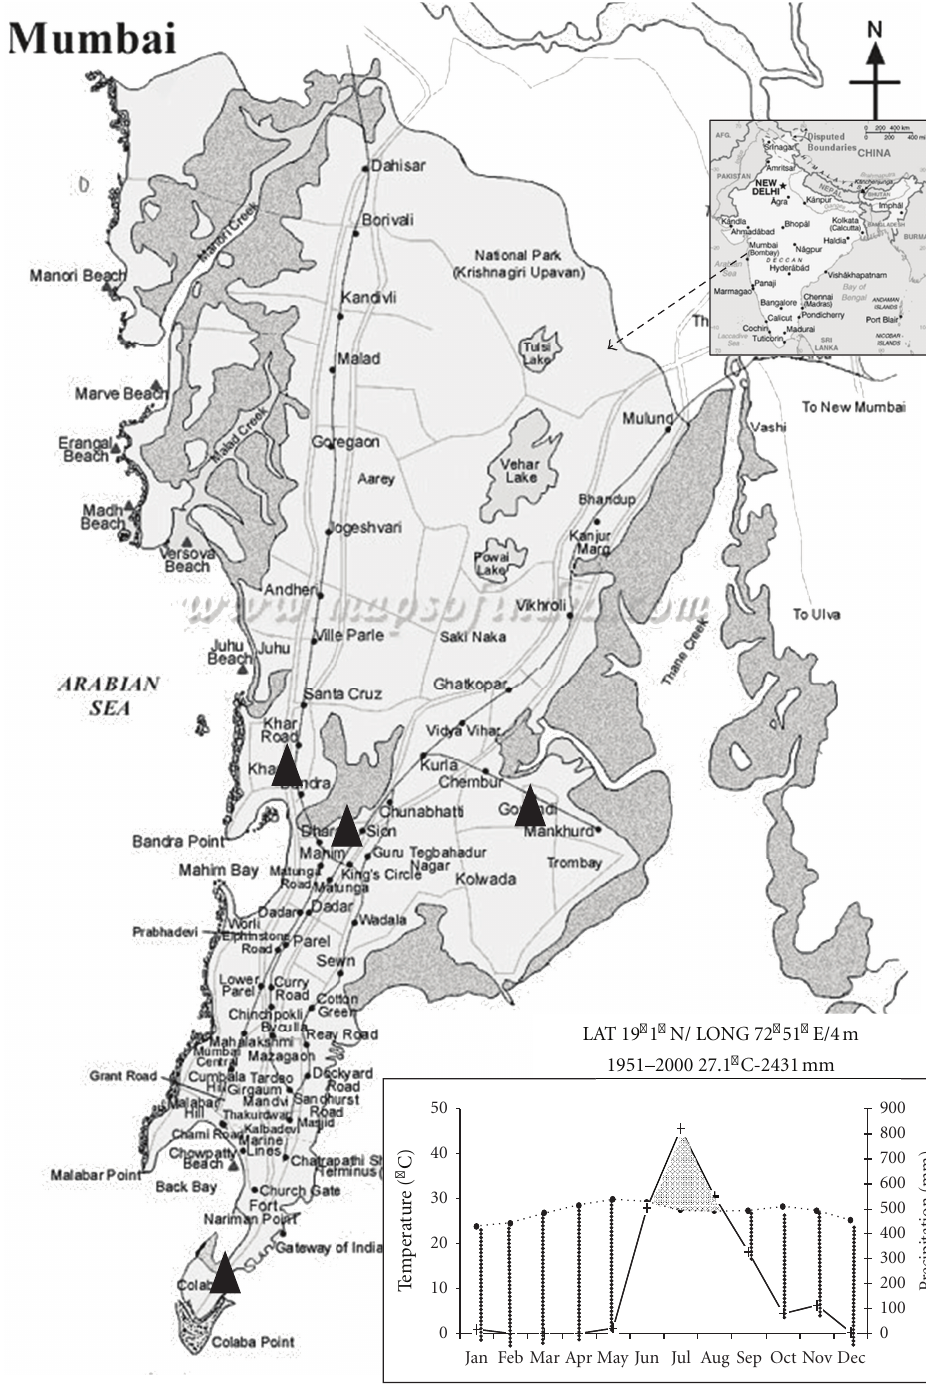
Figure 1: Air-monitoring stations at Mumbai along with the Walter-Liet